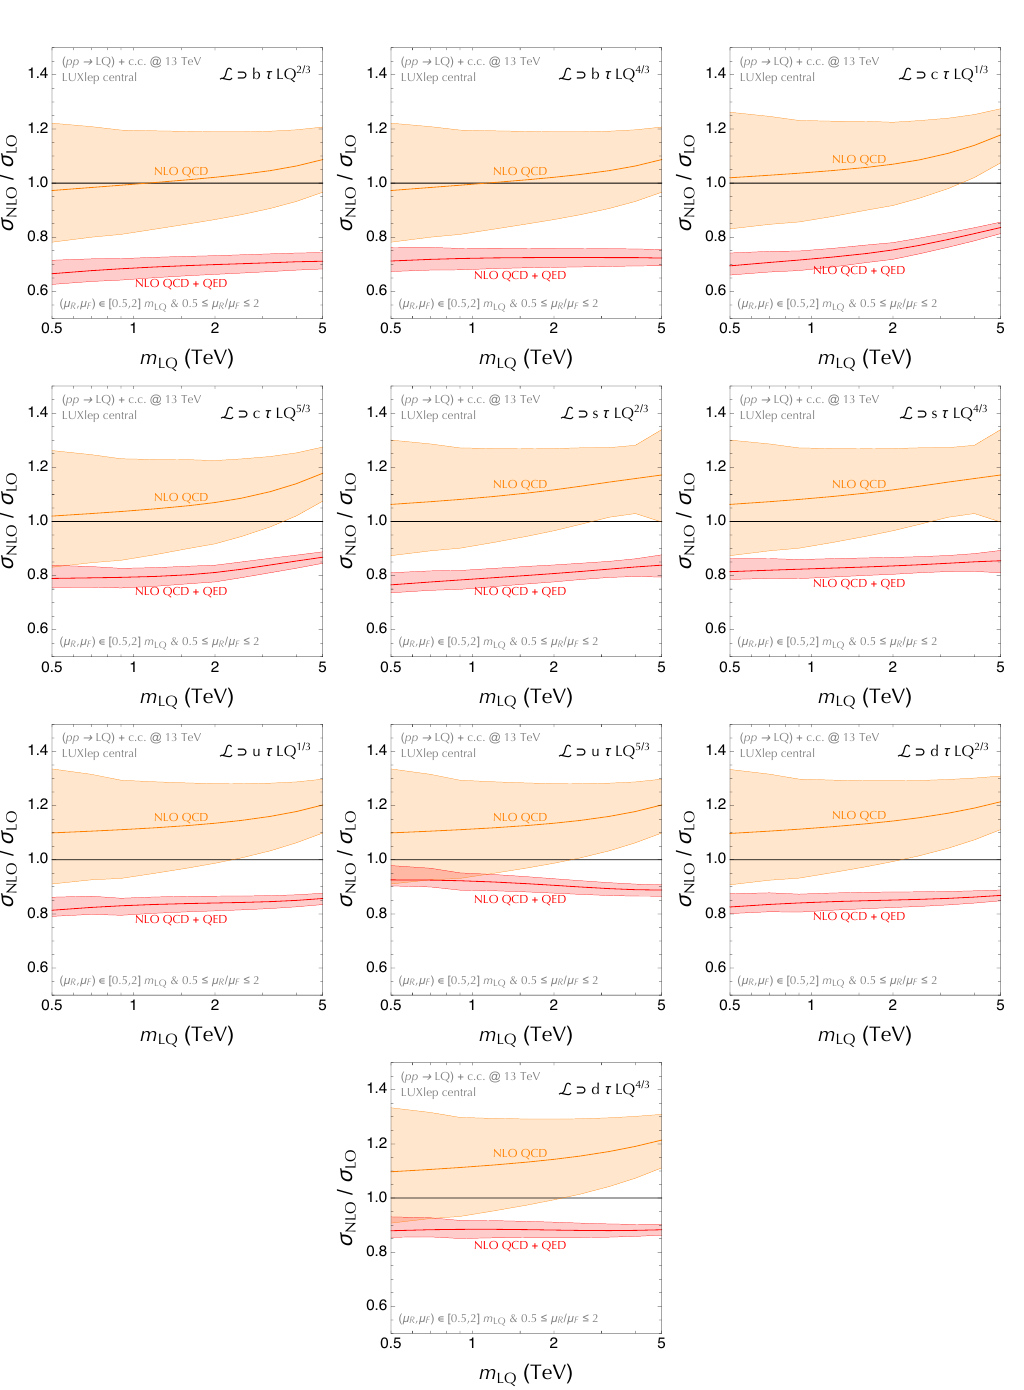
Figure 10 . ( tau ) NLO K -factors ( σ NLO /σ LO ) for resonant scalar leptoquark production at 13 TeV LHC. Shown with orange (red) are the NLO QCD (NLO QCD + QED) predictions normalised to the LO when setting the central scales to µ R = µ F = m LQ . The colored bands are obtained by varying factorisation and renormalisation scales in the NLO calculations within { µ F , µ R } ∈ [0 . 5 , 2] m LQ while respecting 1 / 2 ≤ µ R /µ F ≤ 2 . We use the central PDF set from LUXlep-NNPDF31_nlo_as_0118_luxqed (v2)